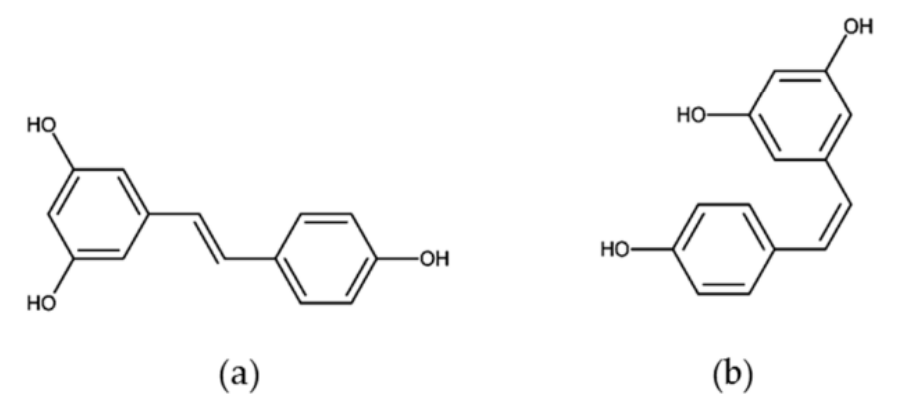
Figure 1. Structure of trans-resveratrol ( a ) and cis-resveratrol ( b ).